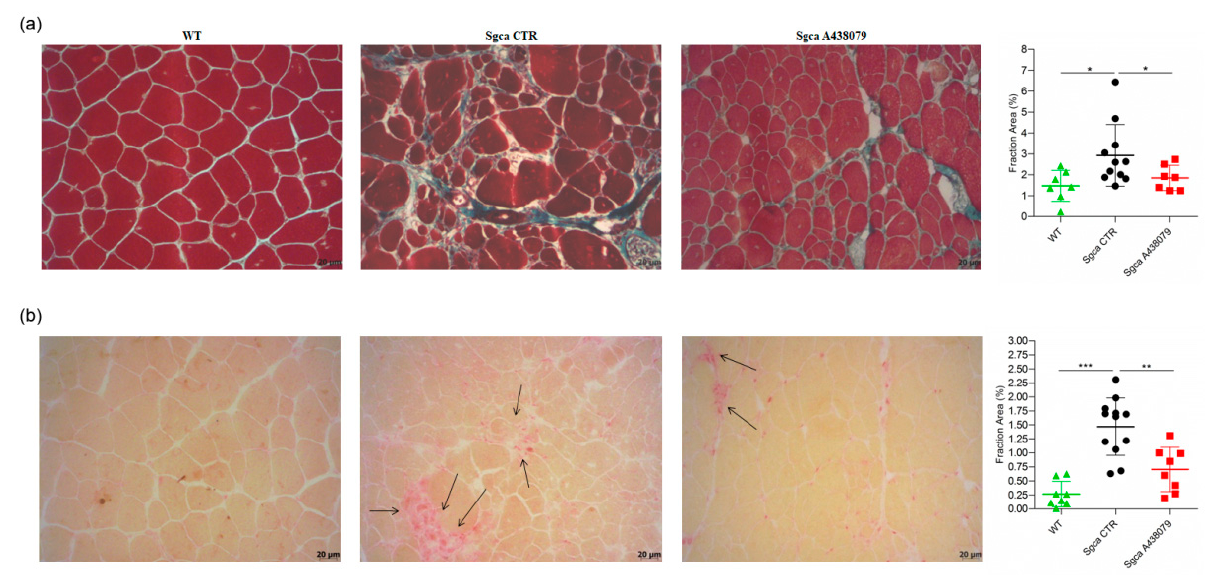
Figure 3. A438079 reduces muscle fibrosis and inflammatory infiltrates in Sgca mice. ( a ): frozen sections of quadriceps from WT ( n = 7), Sgca CTR ( n = 11) and Sgca A438079 ( n = 7) were collected after 24 weeks and stained with a standard Masson trichrome stain protocol. A representative image is shown. Final magnification, 20×. In the right part of the panel ( a ) a graph of the fraction areas of fibrotic green positive signal/fraction area (%) of total section area of muscles evaluated is shown. Data are expressed as mean ± SD. Statistical analysis was performed by one − tailed ANOVA fol- lowed by Tukey’s multiple comparison test. Asterisks indicate statistical significance (*, p < 0.05); ( b ): frozen sections of quadriceps from WT ( n = 8), Sgca CTR ( n = 12) and Sgca A438079 ( n = 8) were collected after 24 weeks and stained with an acid phosphatase technique. A representative image is shown. Black arrow indicates inflammatory infiltrates. Final magnification, 20×. In the right part of panel ( b ), a graph of the fraction areas of inflammatory red positive signal/fraction area (%) of total section area of muscles evaluated is shown. Data are expressed as mean ± SD. Statistical analysis